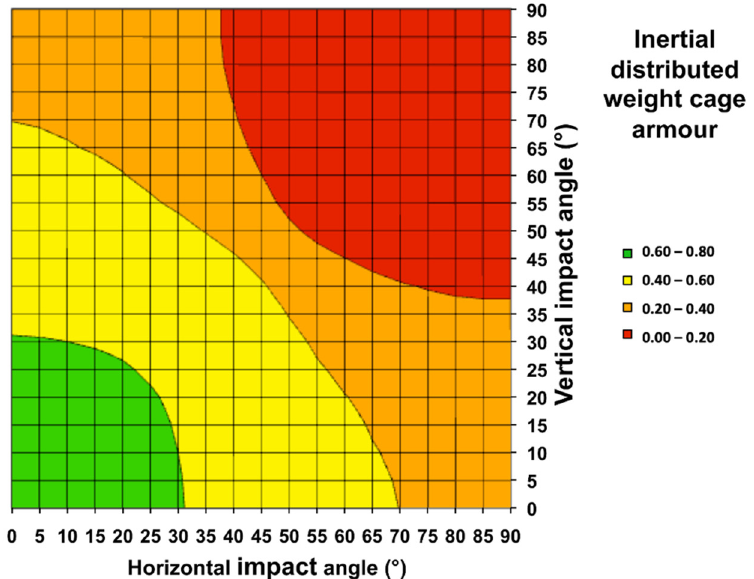
Figure 23. Efficiency of an inertial distributed weight cage armour solution as a function of the horizontal and vertical impact angle.